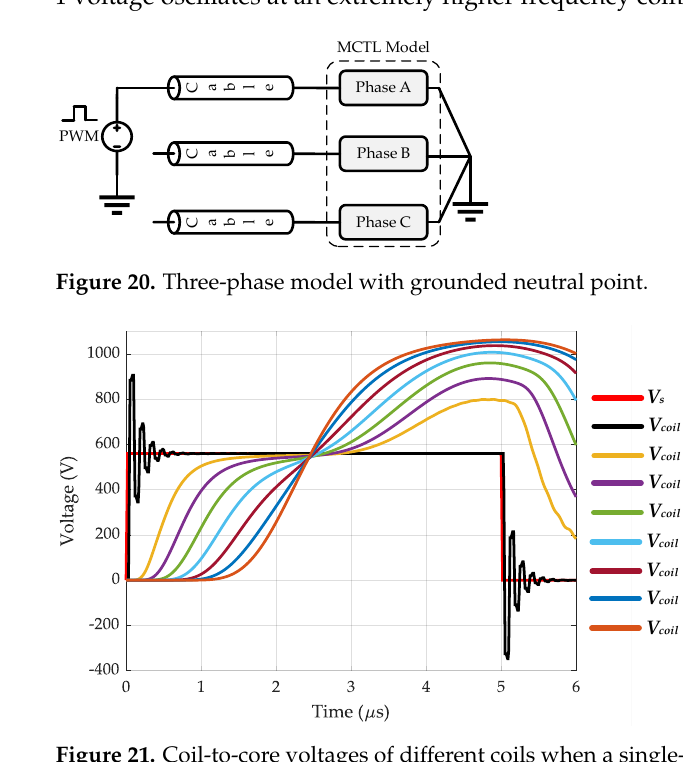
Figure 19. Coil-to-core voltages of different coils when a single-phase model is implemented and is excited by a 560 V PWM voltage with 𝑡 𝑟 = 20 ns and the neutral point is grounded.